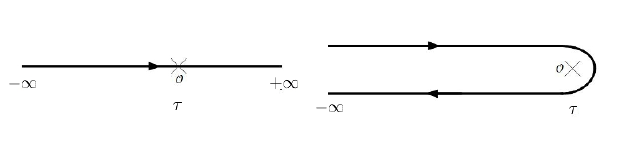
Figure 1 . The S-matrix contour (left) compared to the Schwinger-Keldysh contour (right).